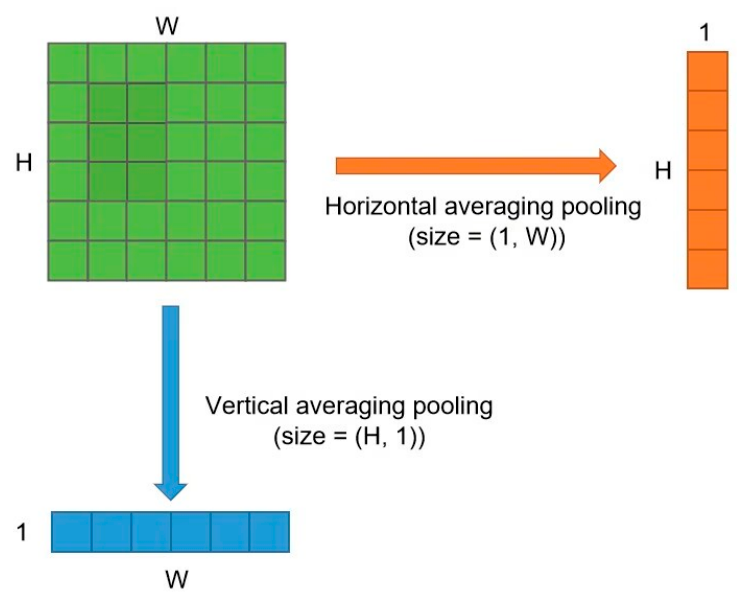
Figure 3. Vector average pooling on feature maps.